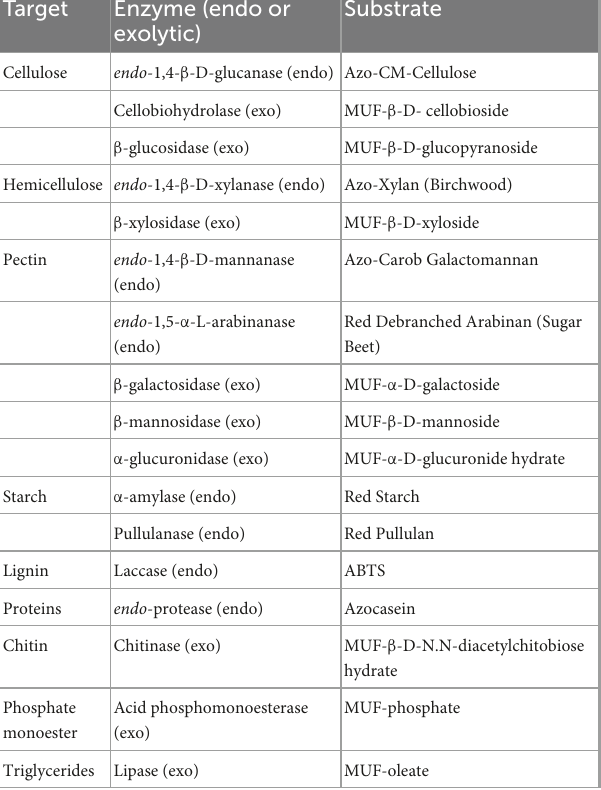
TABLE 1 Extracellular enzyme analyzed in our